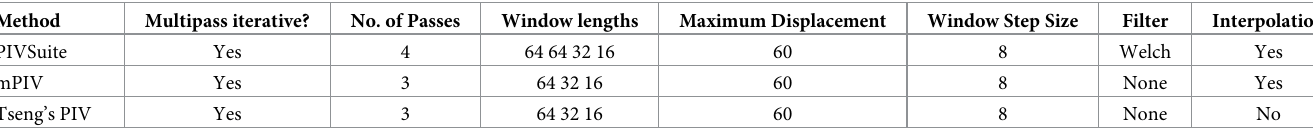
Table 1. Parameters used for PIV